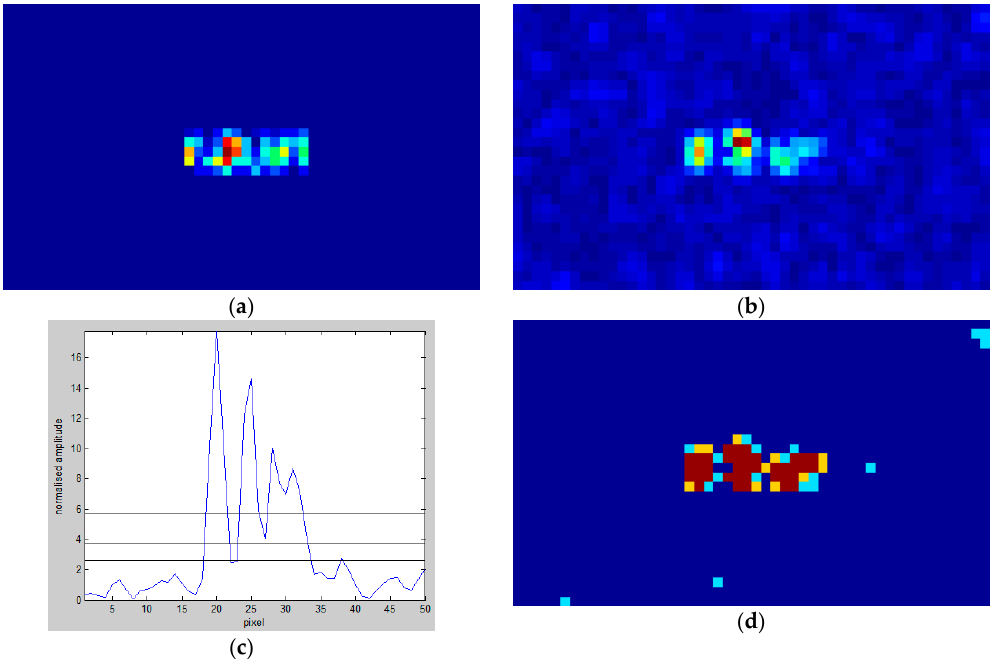
Figure 3. Illustration of the clustering. Only amplitude values are visualized, although ( a , b ) are from complex data. ( a ) Model backscatter distribution of a ship. Each pixel represents a point scatterer, the color from blue to red signifying increasing amplitude, with random phase (not visible). ( b ) Simulated SAR image of the ship on a sea clutter background with ν = 3, L = 1, SNR (target maximum/sea clutter mean) = 71 and using a Kaiser taper function [71] in the spectral domain in both directions with parameter 6.4 and support 90%. The backscatter intensity distribution has changed from the model ( a ) due to fading between neighboring ship pixels. ( c ) Horizontal cross-cut through the center of simulated image with the three thresholds superimposed, from low to high: clustering threshold (clutter mean + 3 sigma), signature threshold (clutter mean + 5 sigma), CFAR detection threshold. ( d ) Clustering result. Red: pixels above the CFAR detection threshold. Orange: ship signature. Cyan in contact with red: ship cluster.